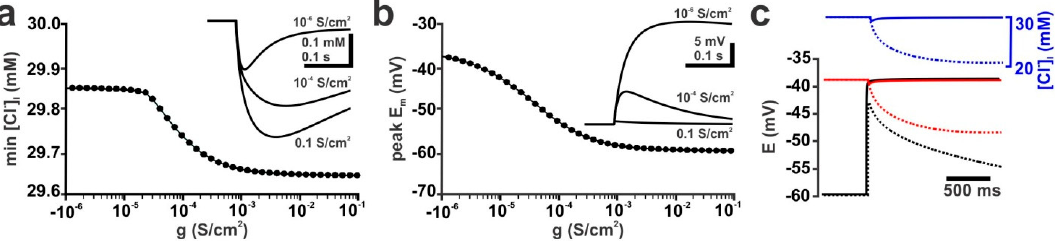
Figure 1. Passive membrane conductance (g pas ) influences GABA-induced [Cl ⁻ ] i transients. At low g pas values, GABAergic currents induce strong depolarization, attenuating the driving force for Cl ⁻ ions and thereby decreasing Cl ⁻ fluxes. ( a ) The [Cl ⁻ ] i transients induced by a single GABAergic stimulation (g = 0.789 nS, τ = 37 ms, P HCO3 = 0, [Cl ⁻ ] i = 30 mM) show a strong dependency on g pas . Three typical traces are displayed as inset. ( b ) The GABA-induced membrane depolarization also shows a sigmoidal dependency on g pas . ( c ) Effect of g pas on E m (black lines), E Cl (red lines) and [Cl ⁻ ] i (blue lines) in an isolated dendrite using constant GABAergic currents (g GABA = 0.1 µS). Note that at low g pas values (0.1 nS/cm 2 , solid lines) E m approximates E Cl , while at high g pas (18 mS/cm 2 , dashed lines) E m stays below E Cl . Accordingly [Cl ⁻ ] i shows only a small transient change at low g pas , while a steady decline in [Cl ⁻ ] i occurs at high g pas .